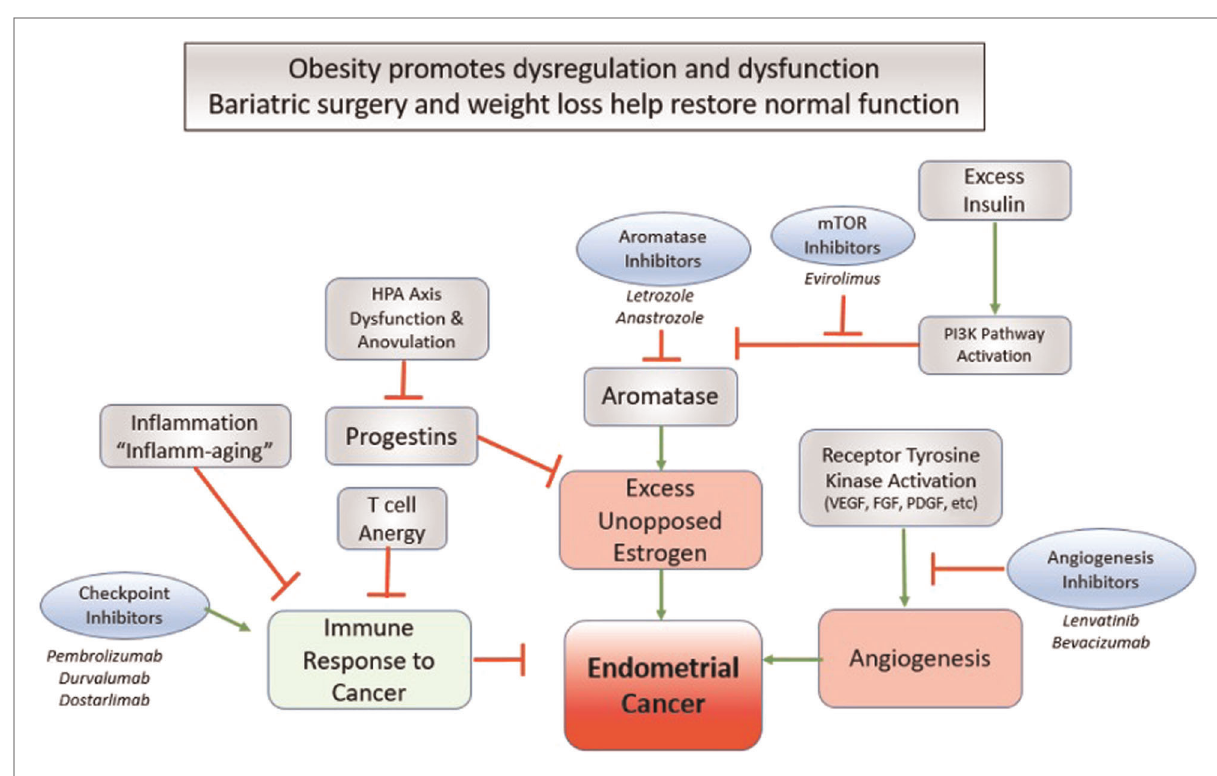
FIGURE 4 Bariatric surgery as a targeted therapy for endometrial cancer amelioration. Several novel advancements in targeted therapy for advanced endometrial cancer highlight critical pathways that may be in kind targeted effectively by bariatric surgery and successful weight